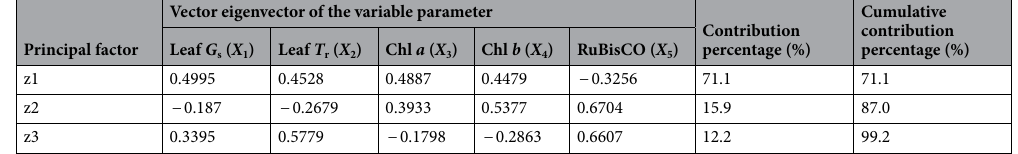
Table 5. The principal factors which affected leaf P n